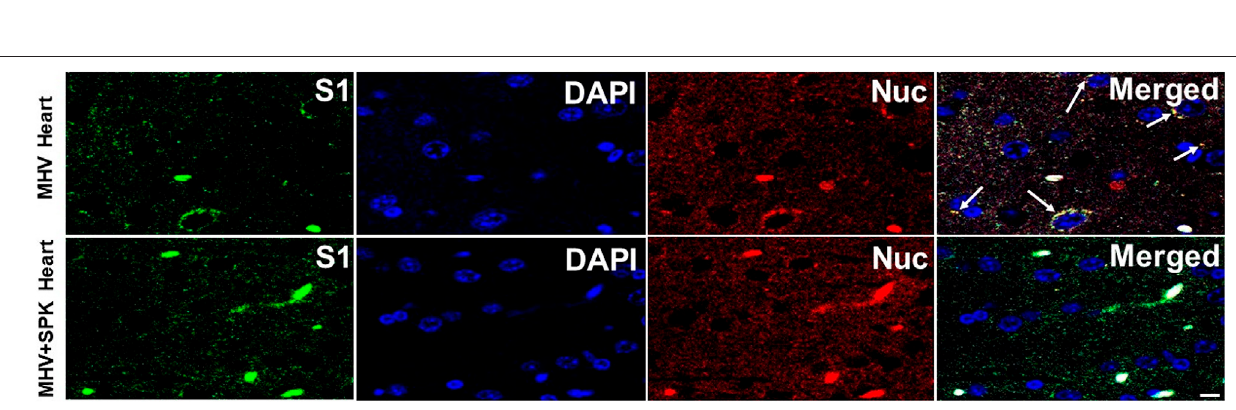
Frontiers in Pharmacology |